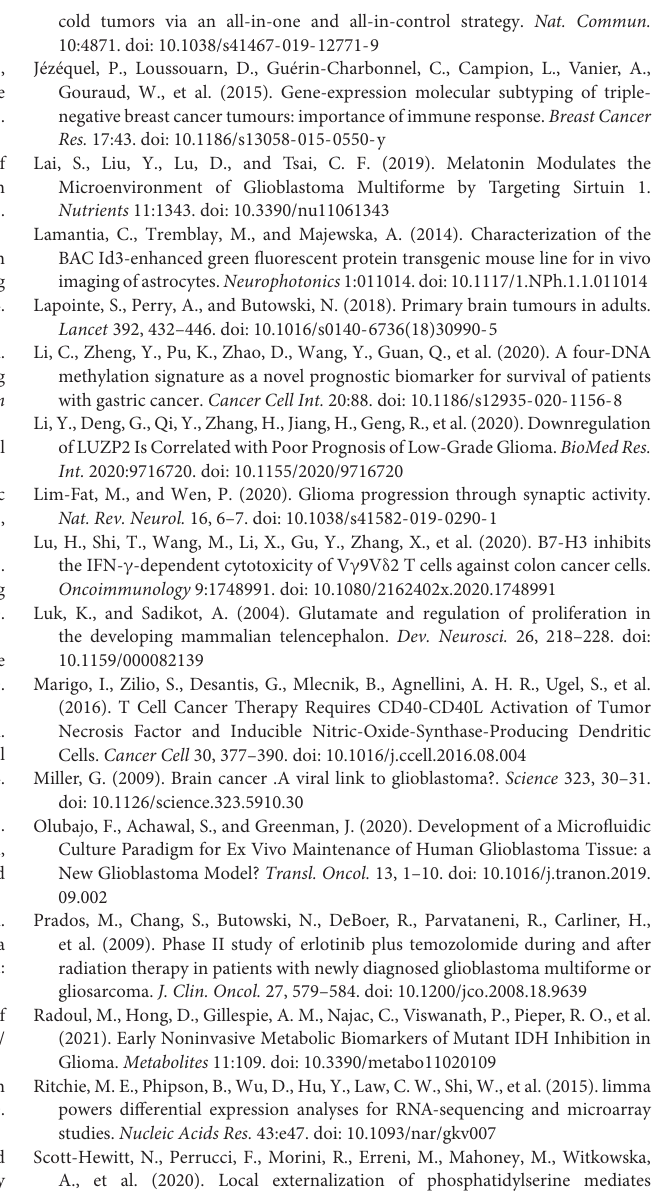
Supplementary Figure 1 | CNV and SNP of GSRGs in LGG according to cBioPortal database. T, tumor; N, normal; CNV, copy number variation; SNP, single-nucleotide